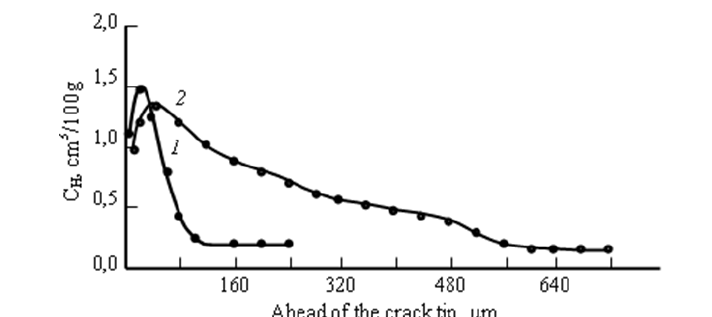
C ahead of the crack tip on the crack extension line: line 1 corresponds to Figure 4: Hydrogen distribution H 2 corresponds to 68 K  MPa m max